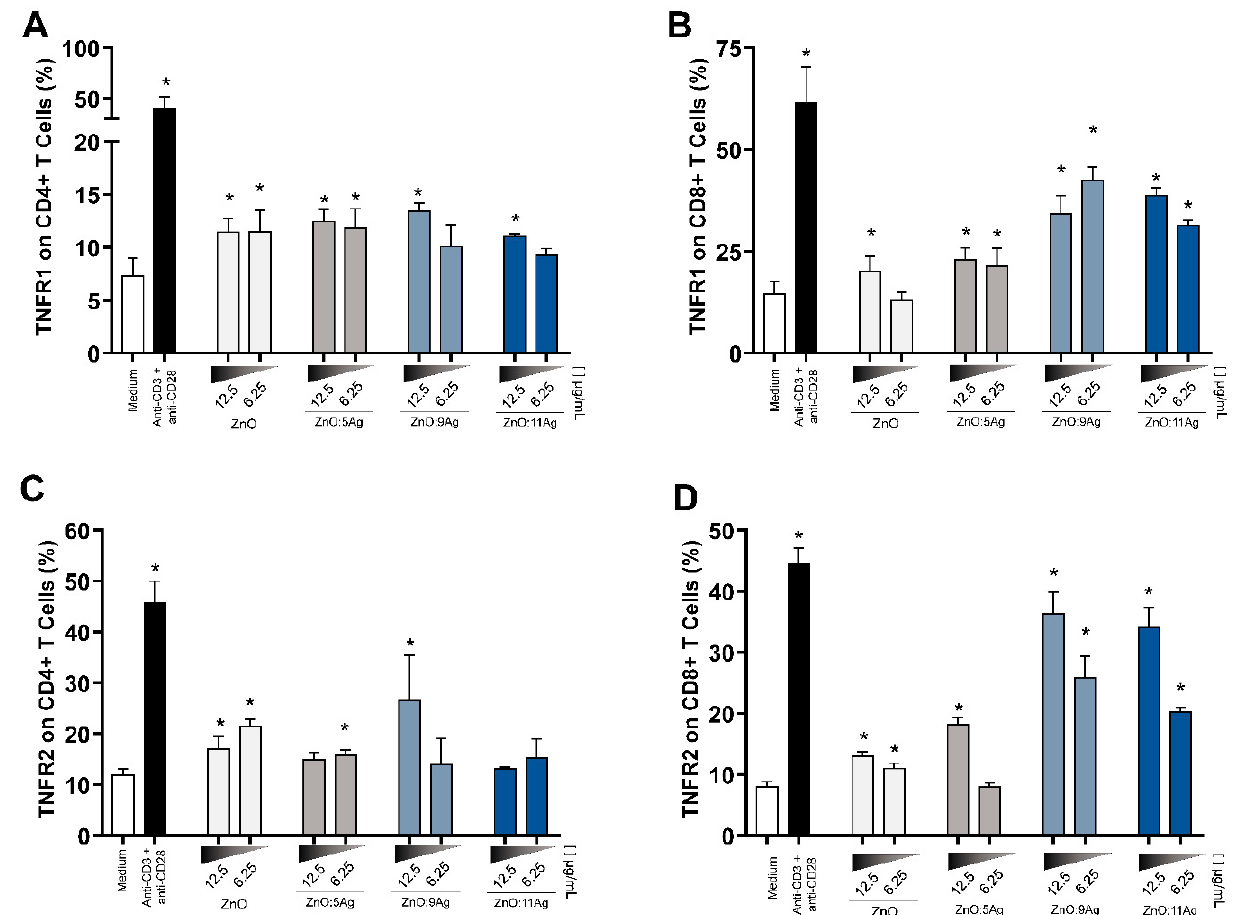
Figure 5. Nanomaterials promote increased expression of TNF- α receptors in T lymphocytes. Ex- pression levels of TNFR1 (Figure 4A,B) and TNFR2 (Figure 4C,D) were determined by flow cytom- etry in CD4+ and CD8+ T lymphocytes from treated PBMCs for 72 h. The results are expressed as the mean fluorescence intensity ± SEM. The Mann–Whitney test was applied, and values of p < 0.05 (*) were considered significant when compared to untreated cell culture (medium). Untreated cells (medium) and cells treated with anti-CD3 and anti-CD28 stimuli were used as negative and positive controls, respectively. ( A ) All treatments and doses (except ZnO:11Ag NCPs at 6.25 µ g/mL) upregulated TNFR1 expression in CD4+ T lymphocytes. ( B ) In CD8+ T cells, all nanoformulations (except ZnO nanocrystals at 6.25 µ g/mL) upregulated the expression of TNFR1, with this production being more significant in cells treated with ZnO:9Ag NCPs. ( C ) CD4+ TNFR2+ T lymphocytes were increased in cultures treated with ZnO nanocrystals (at 12.5 µ g/mL and 6.25 µ g/mL), ZnO:5Ag NCPs (at 6.25 µ g/mL) and ZnO:9Ag NCPs (at 12.5 µ g/mL). ( D ) CD8+ T cells expressed more TNFR2 than the control group in all tested nanoformulations in a dose-dependent manner, with the ZnO:9Ag and ZnO:11Ag NCPs at 12.5 µ g/mL having the highest